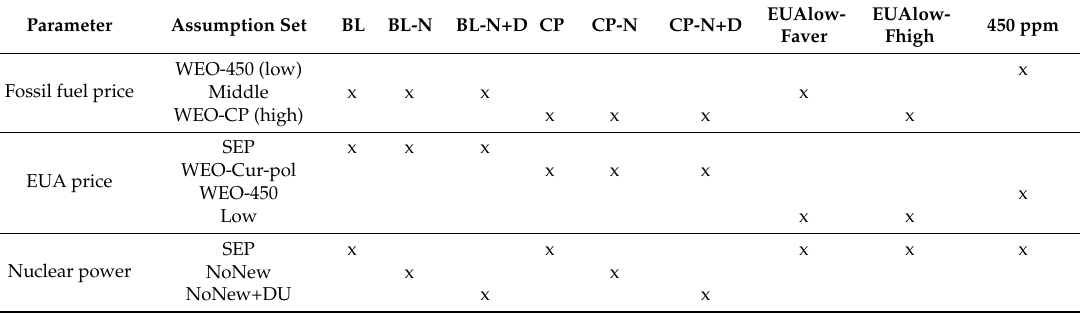
Table 3. Assumption sets for each of the TEL